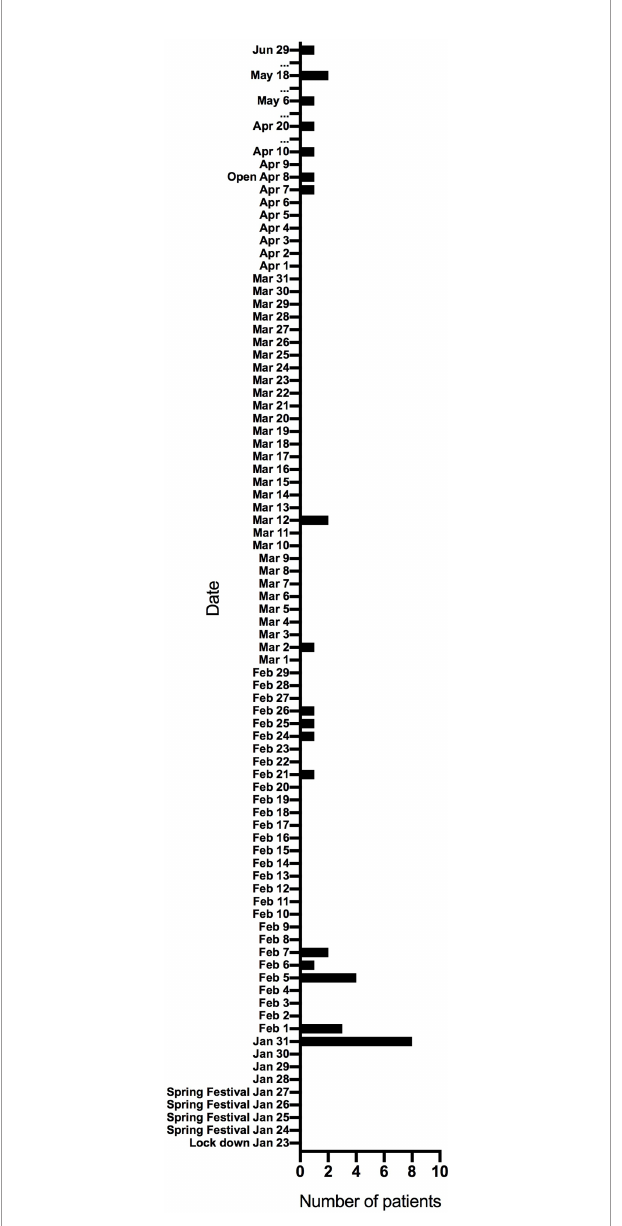
FIGURE 1 | The date and number of patients who came back for further radiotherapy after radiotherapy was interrupted due to the COVID-19